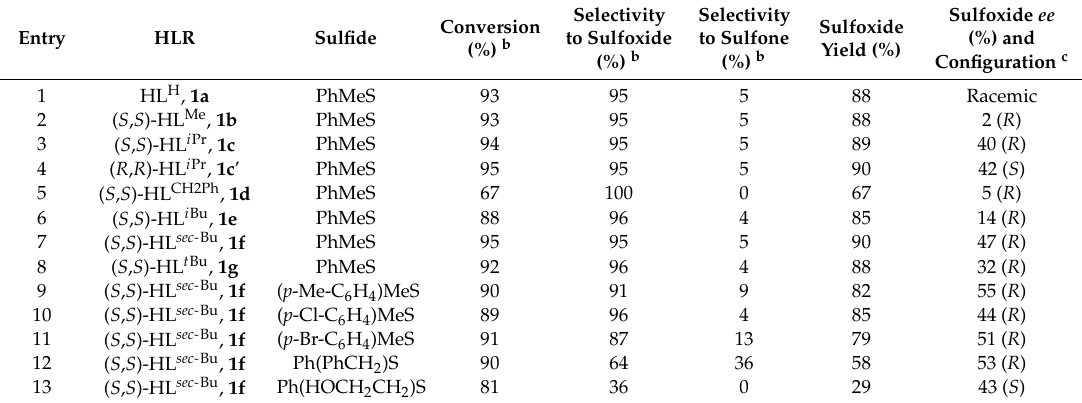
Table 1. Enantioselective oxidation of different sulfides with the system [MoO(O 2 ) 2 (H 2 O) n ]/H 2 O 2 / HL R /[PPh 4 ]Br a